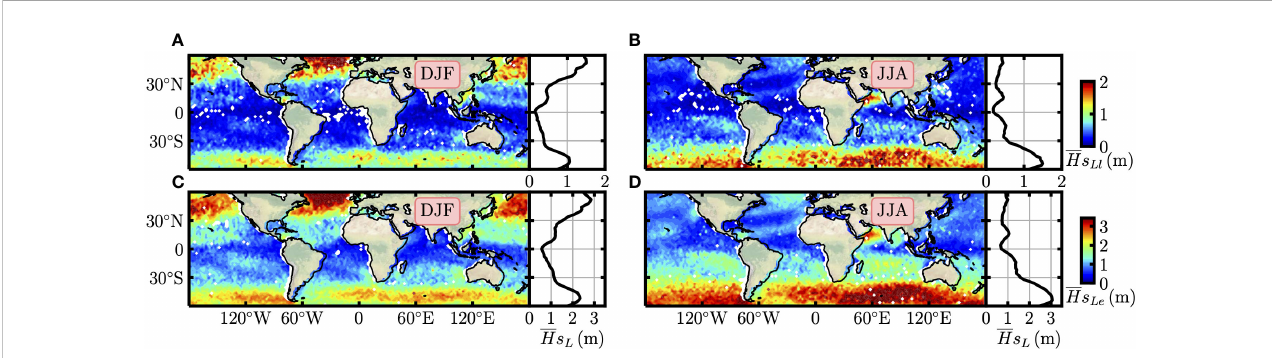
FIGURE 11 The global distributions (cid:1) Hs Ll predicted with the power-law models derived from linearly decomposed wind waves in (A) DJF and (B) JJA. (C, D) are the (cid:1) Hs Le estimated with the power-law models extracted from the wind waves decomposed by the energy conservation theory. The meridional variations are shown in the right panels. The model input U 10 is the seasonal averaged JASON